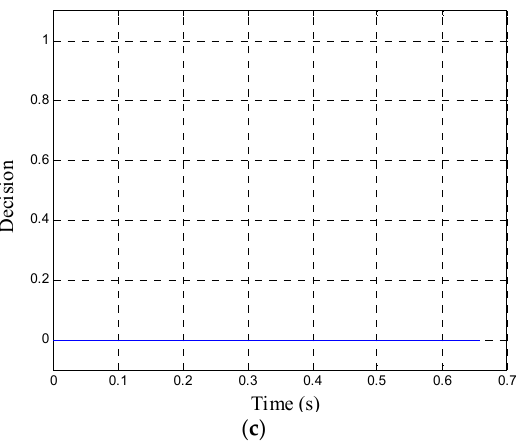
Figure 10. Recorded fault case no.2: ( a ) voltage in open delta VT connection; ( b ) measured flux amplitude; ( c ) proposed algorithm operation.